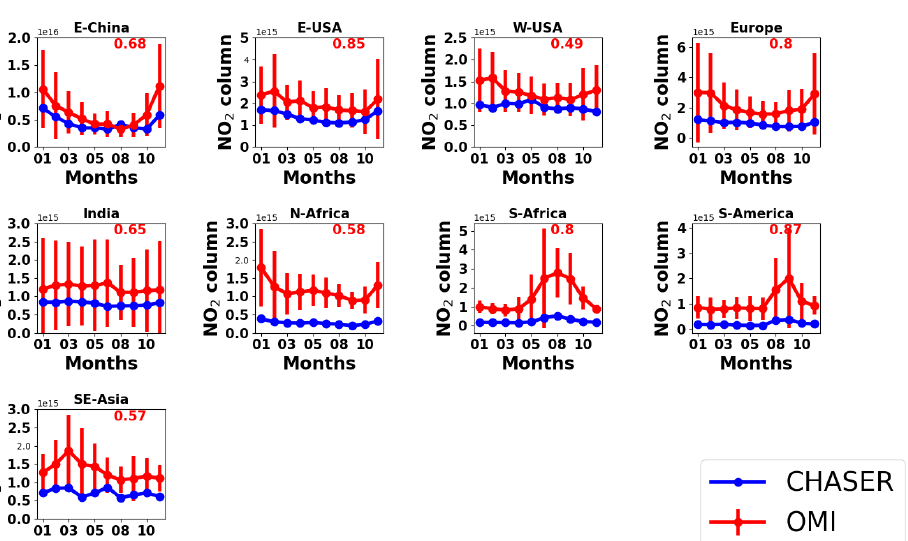
Figure 8. Seasonal variations in tropospheric NO 2 columns in E China (30–40 ◦ N, 110–123 ◦ E), E USA (32–43 ◦ N, 71–95 ◦ W), W